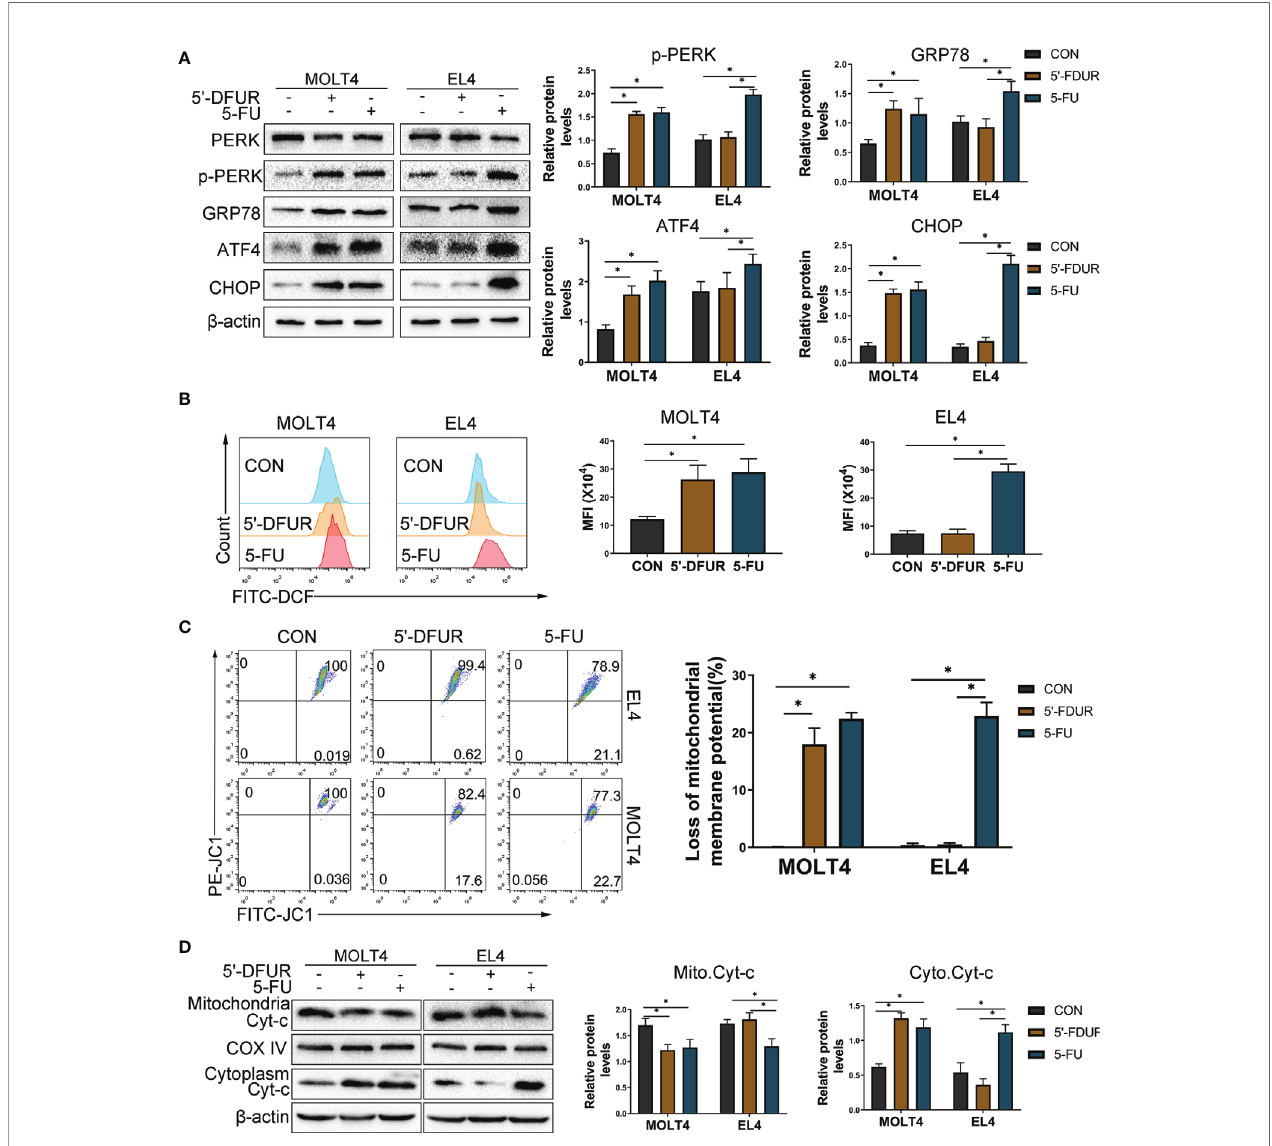
FIGURE 6 | CAP increases T cell ERS, ROS generation, mitochondrial membrane depolarization, and induces mitochondria-mediated apoptosis. EL4 and MOLT4 cells were exposed to 5 ′ -DFUR (0 m M and 50 m M) or 5-FU (0 m M and 30 m M) for 48 (h) (A) Endoplasmic reticulum stress-related proteins PERK, p-PERK, GRP78, ATF4, and CHOP were detected by western blot analysis. (B) The ROS level was detected with fl uorescent probes (DCFH-DA) using fl ow cytometry. (C) The proportion of cells with reduced mitochondrial membrane potential was detected using fl ow cytometry. (D) Cytochrome C expression in the cytoplasm and mitochondria was detected by western blot analysis. Data are presented as mean ± SD. * P <